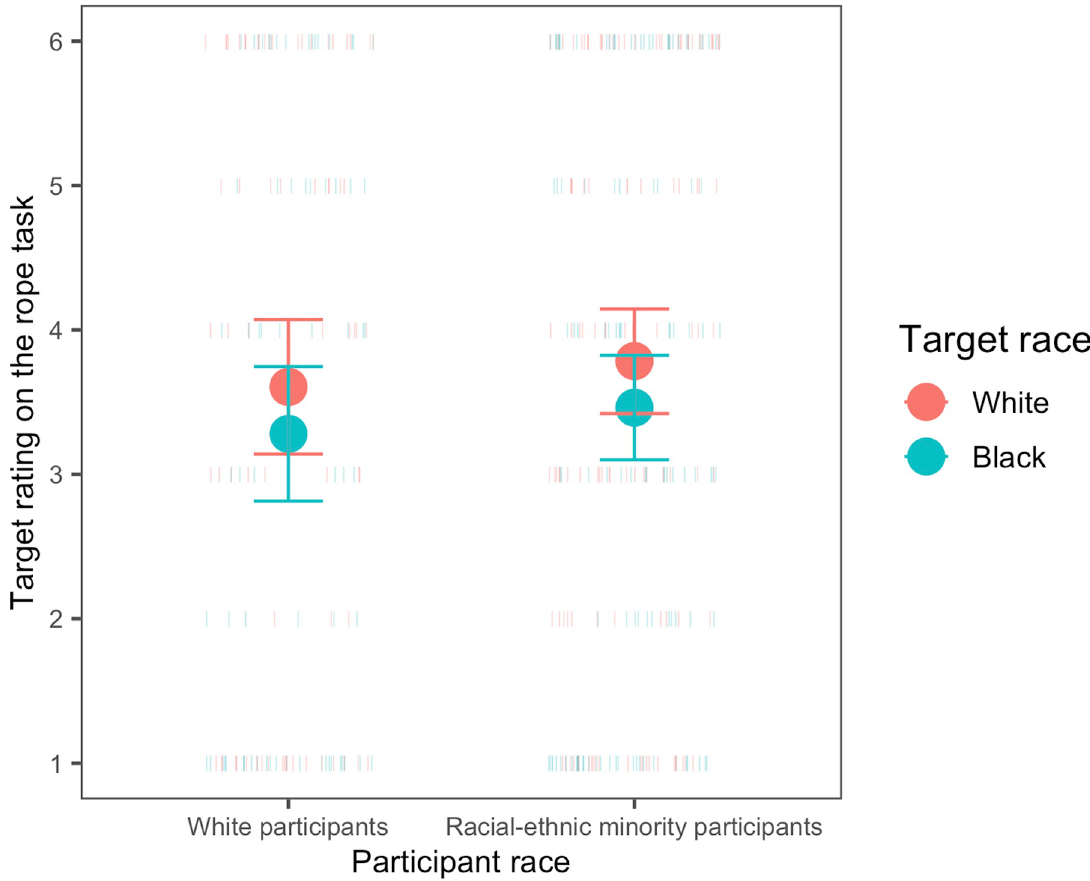
Fig 5. Responses as a function of participant race on the rope task. Circles represent the means for each group, and error bars represent 95% confidence intervals around the means; dashes represent individual participants.